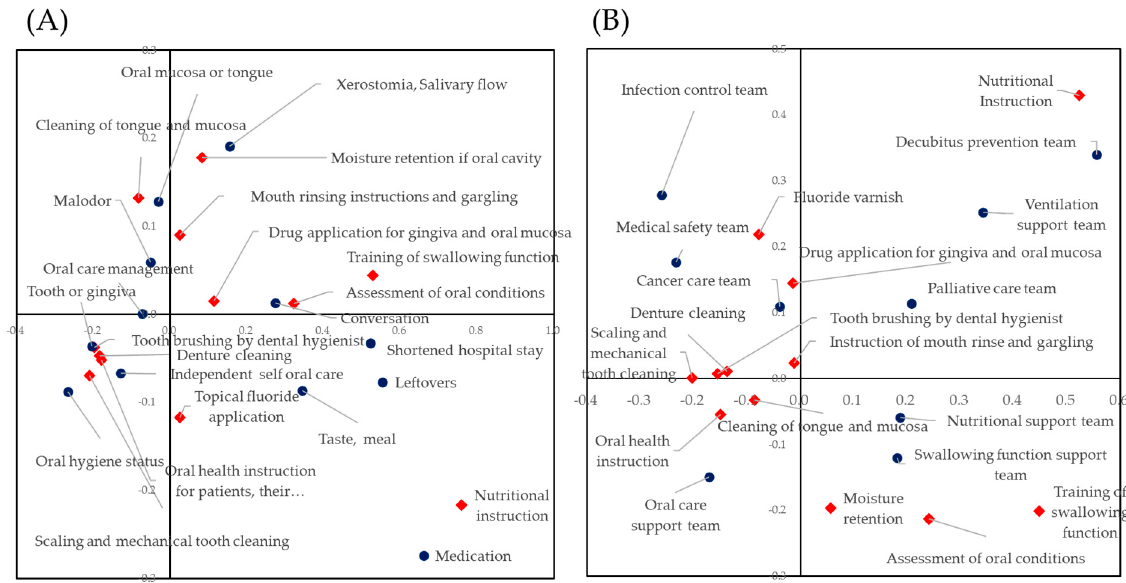
Figure 2. Biplots of treatments and self-assessed effects ( A ) and treatments and participation in a medical team ( B ). Red plots correspond to the treatment of perioperative oral care management. Navy plots correspond to the self-assessed effect of perioperative oral care management. Closely located plots were highly coincident.